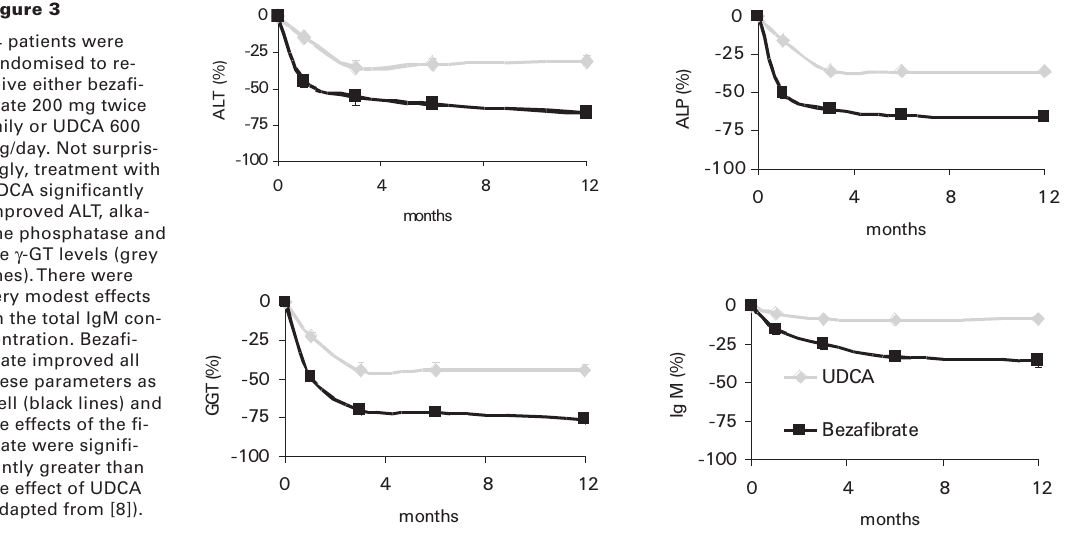
nal tract, and long-term treatment with ur- sodeoxycholic acid decreases the activity of the HMG-CoA reductase, the key enzyme in choles- terol synthesis. Also, UDCA increases the expres- sion of LDL receptors on the hepatocytes and may also increase the conversion of cholesterol to bile acids.